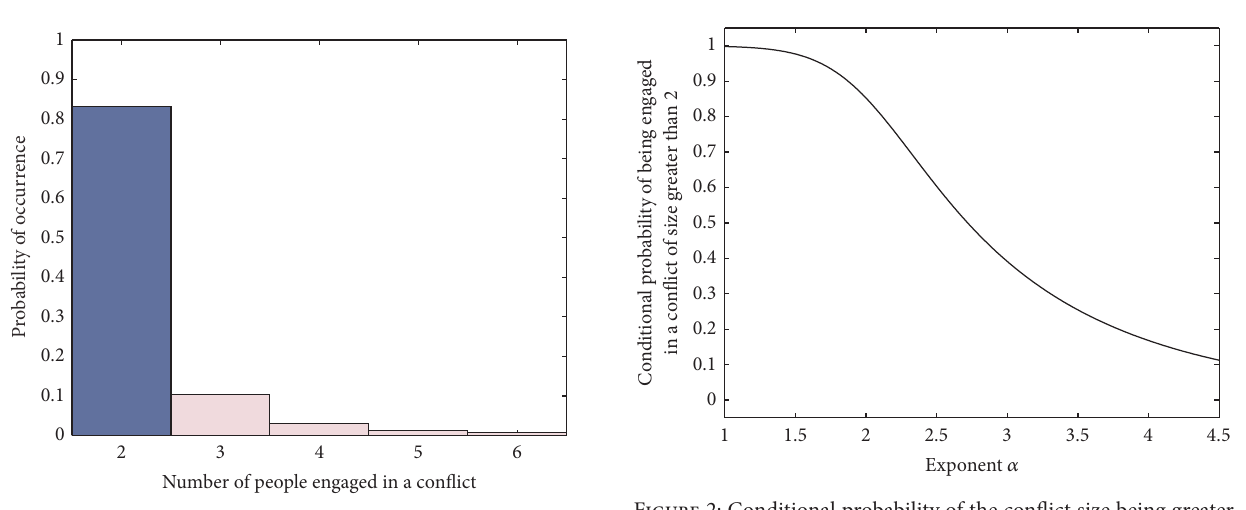
Figure 2: Conditional probability of the conflict size being greater than 2, given that an individual is engaged in a